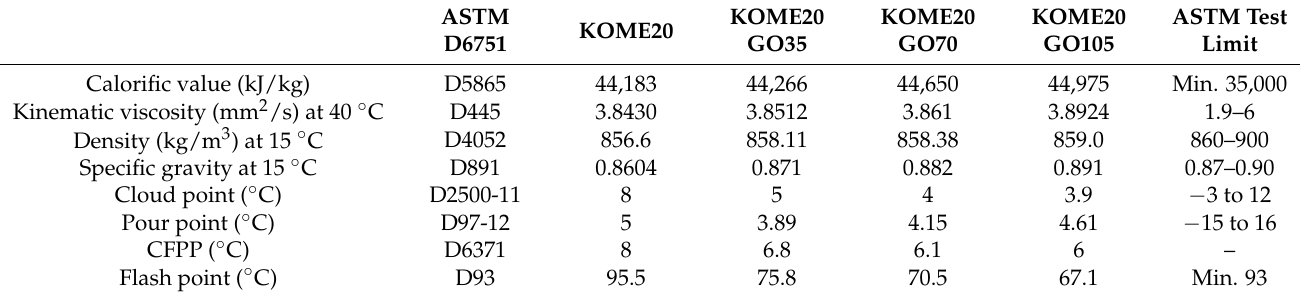
Table 7. Fuel properties of Karanja Biodiesel-Diesel-Nano blends by DT